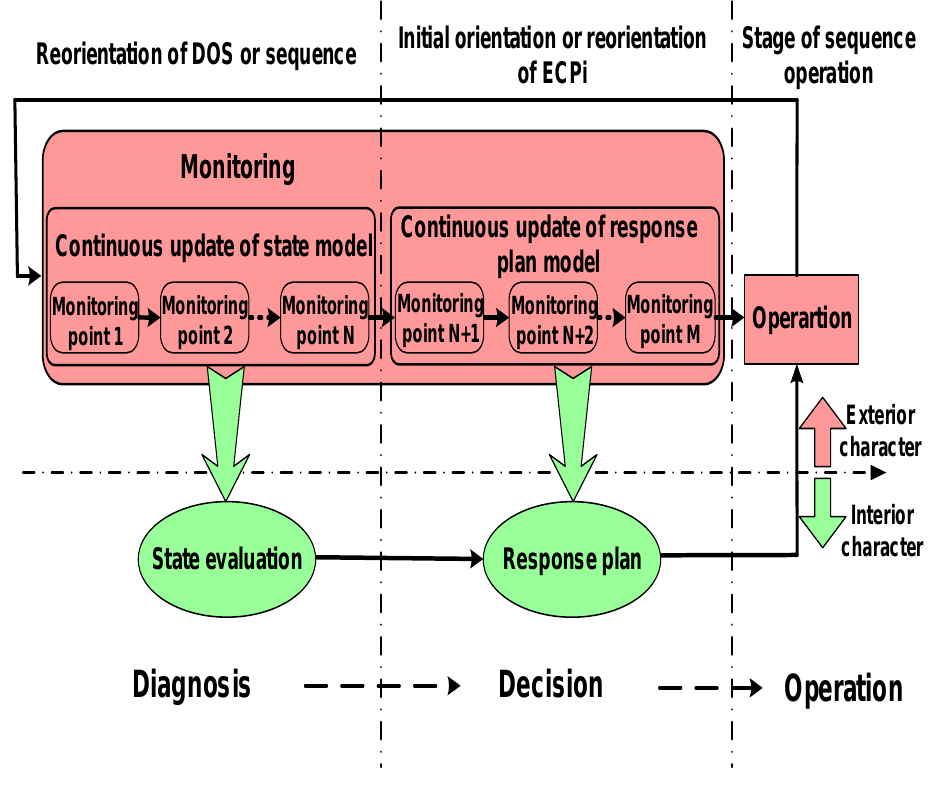
Figure 5. RO1 cognitive behavioral model.